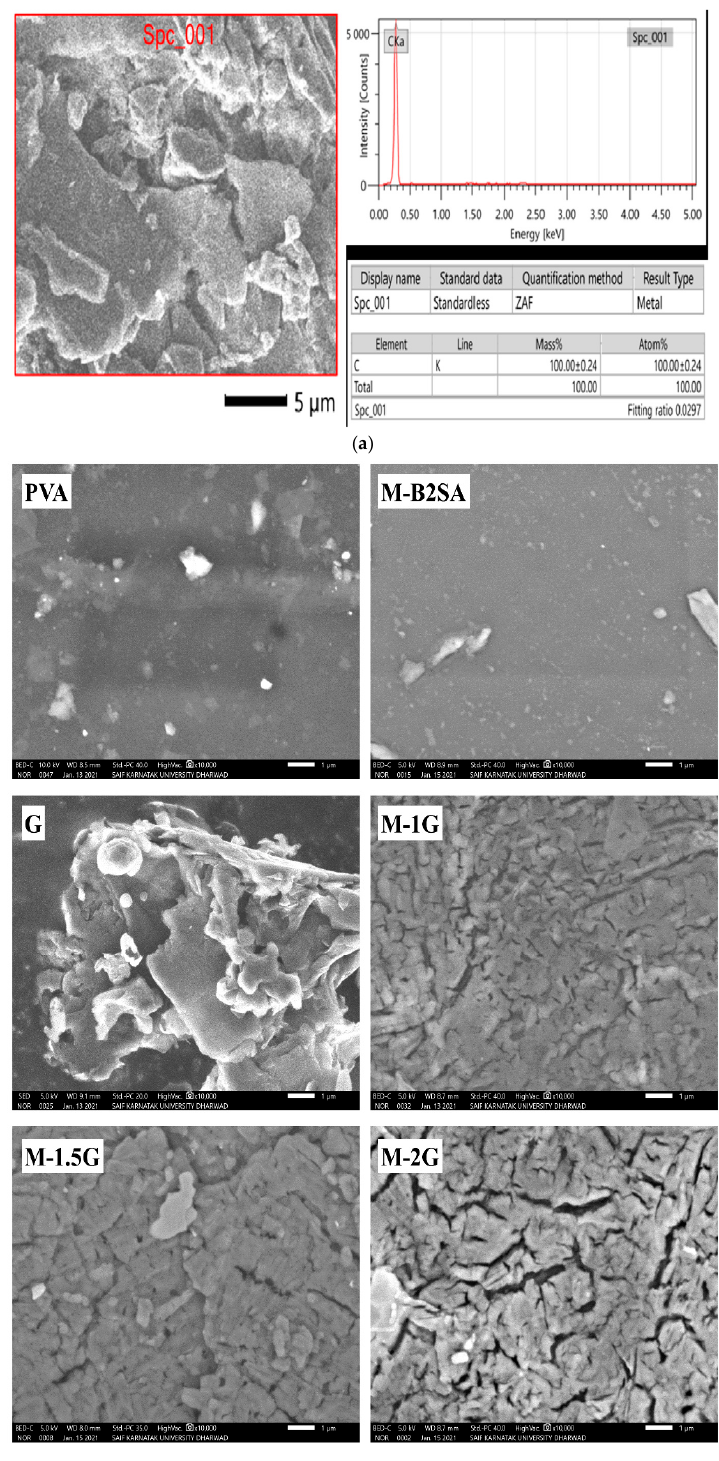
Figure 7. ( a ) SEM and energy dispersive X-ray (EDX) specta of graphene. ( b ) SEM micrographs of PVA; graphene; sulfonated PVA–TEOS (M-B2SA); and graphene-loaded, sulfonated PVA–TEOS hybrid membranes: (M-1 G) 1 mass%; (M-1.5 G) 1.5 mass%; (M-2 G) 2 mass% of